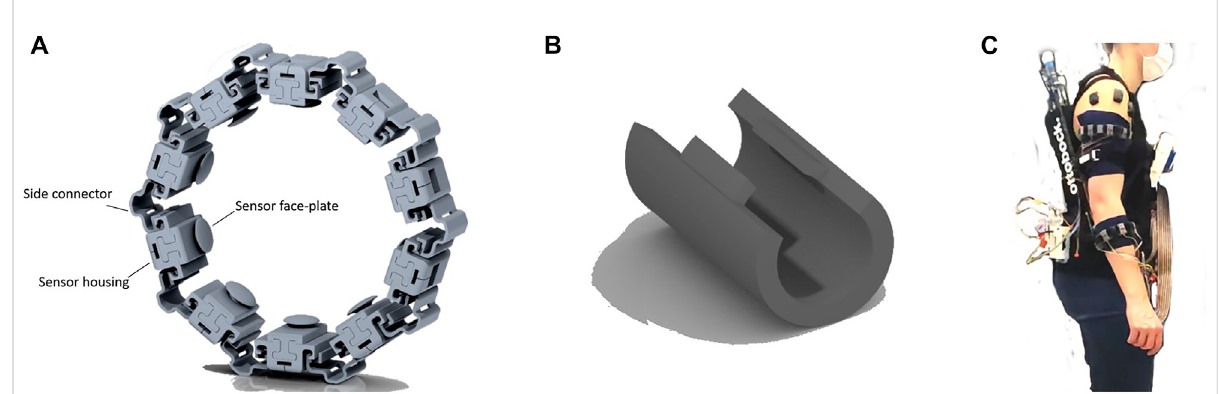
FIGURE 3 CAD view of the bracelets and bracelet elements. (A) Render of an assembled FMG bracelet with 10 sensing elements. (B) Render of one rigid clipwhichcanbeusedtoclampthelateralconnectorsto fi tthebracelettolimbsoflowercircumference. (C) FullFMGsetupaswornbyaparticipant during the experiment. Notice also the EMG sensor probes worn on the